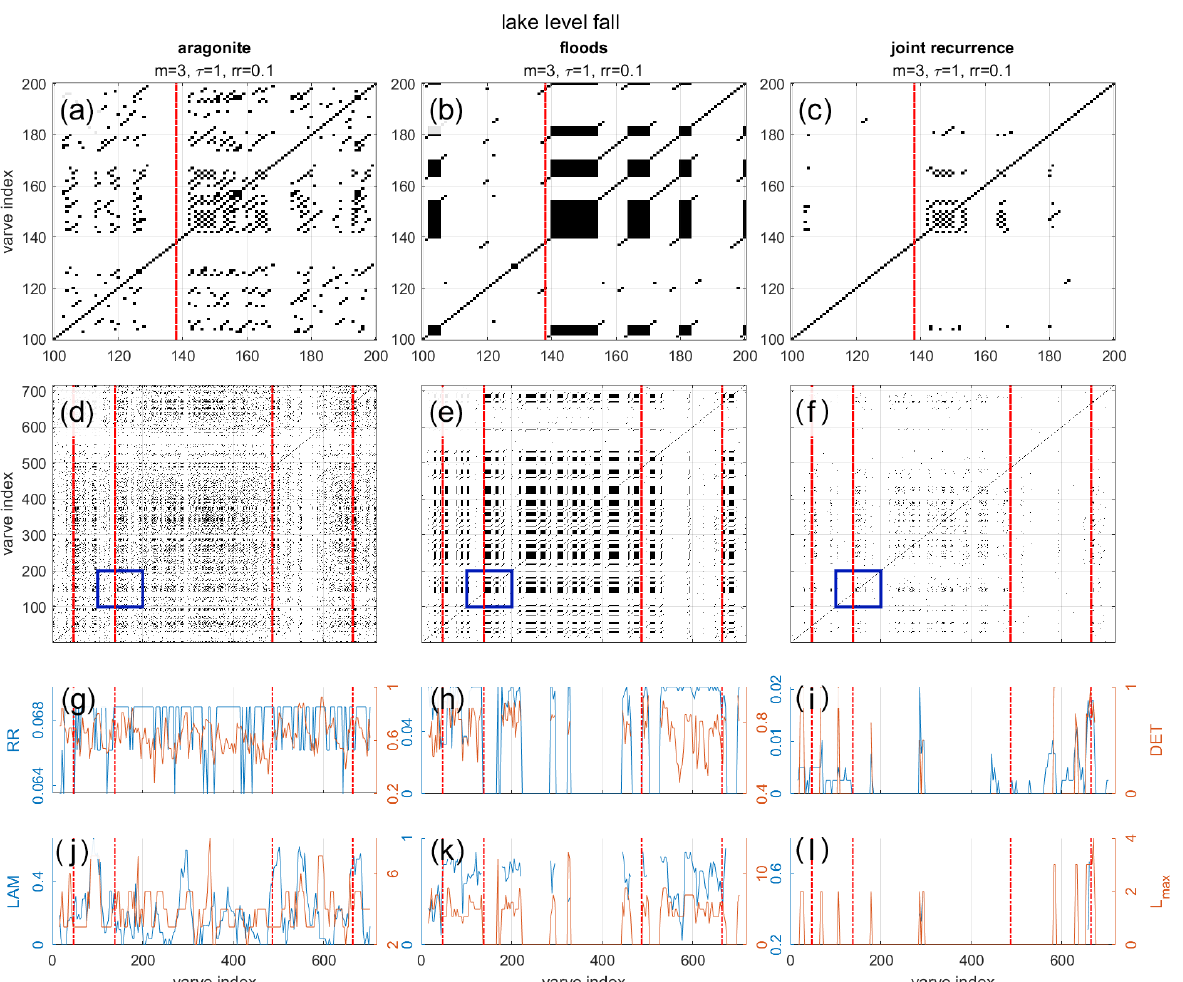
Figure 6. (a–c) Enlarged segments of the recurrence plots of the studied lake-level fall for aragonite thickness (a) , flood frequency (b) , and the joint recurrence plot for the two proxies (c) . (d–f) Recurrence plots of the aragonite thickness (d) and flood frequency (e) and the joint recurrence plot for the two proxies (f) , with blue rectangles indicating the extent of data presented in (a) – (c) . Note the parallel diagonal lines that characterize series of the aragonite thickness (a, d) and point to an inherent oscillatory behaviour, whereas the flood series (b, e) forms sporadic points and polygons that reflect a more chaotic or random behaviour. (g–i) The recurrence rate (RR) and the determinism (DET) coefficient calculated using a running window size of 30 years and a single-year step for aragonite thickness (g) , floods (h) , and their joint recurrence (i) . (j–l) The laminarity (LAM) and the maximum length of the diagonal line within the sub-matrix ( L max ) coefficient using a running window size of 30 years and a single-year step for aragonite thickness (j) , floods (k) , and their joint recurrence (l) . The analyses were performed after detrending the data by subtracting the RC (1) of the SSA and normalizing to zero mean and unit standard deviation. The selected parameters for the embedding are m (dimension), τ (delay), and ε (threshold) used for space phase reconstructions and depicted in the figure. Red lines represent possible clusters identified independently of the recurrence